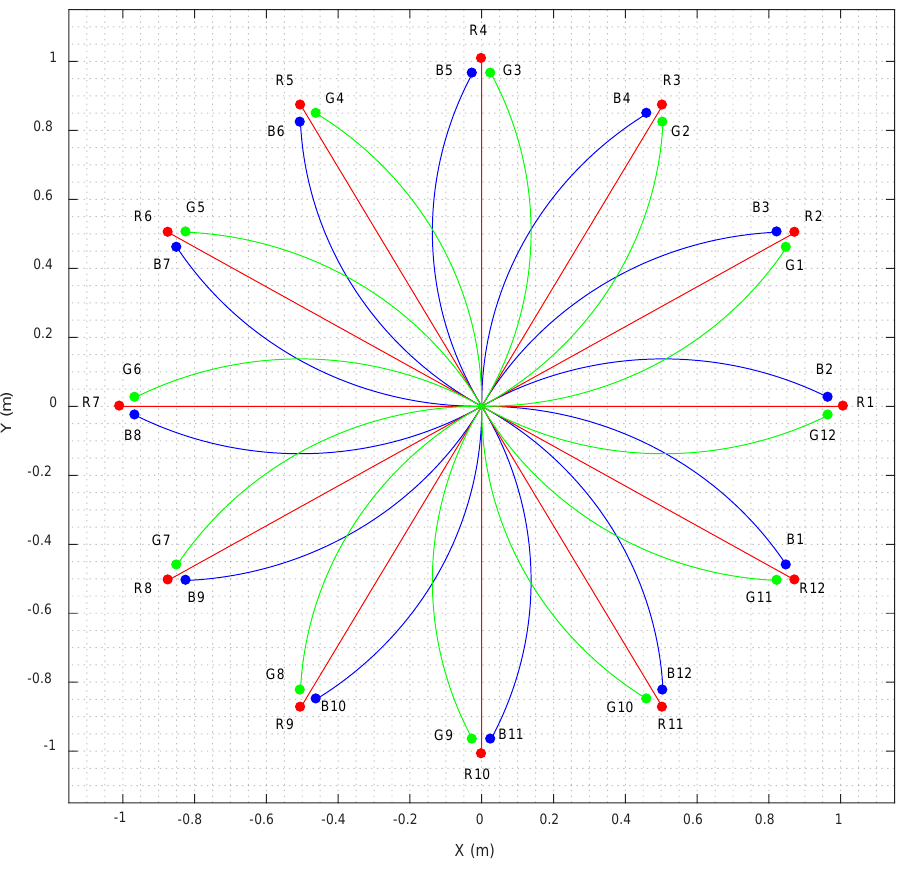
Figure 9. Representation of the ideal flower-shaped trajectories proposed to calibrate the odometry of the omnidirectional mobile robot APR-02.